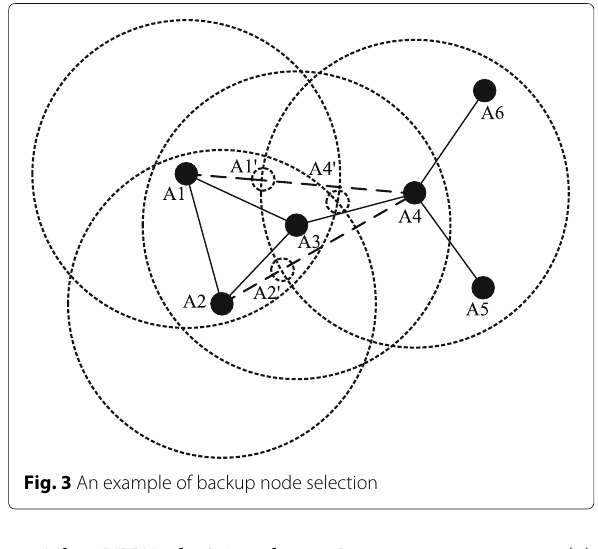
Fig. 3 An example of backup node selection